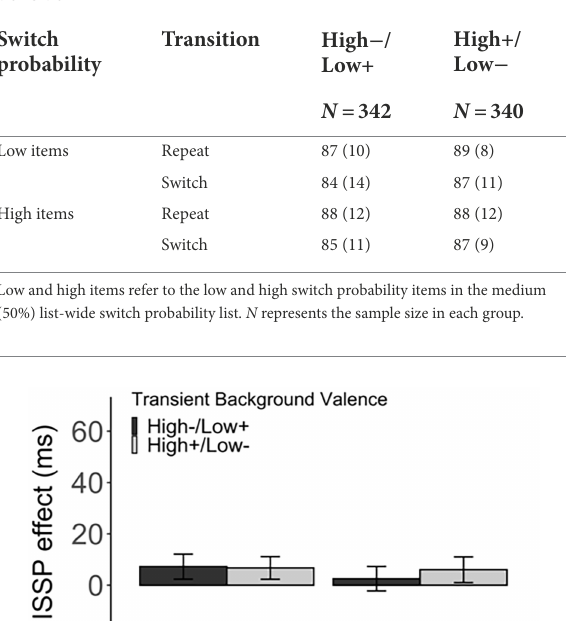
TABLE 6 Mean accuracy (%) with standard deviations in Experiment 2 as a function of background valence, switch probability, and transition.